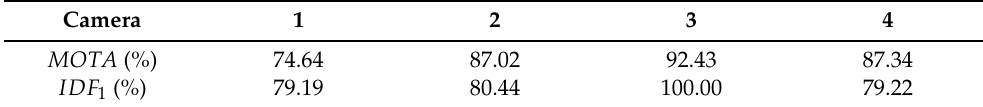
Table 1. MOTA and IDF 1 of different cameras.